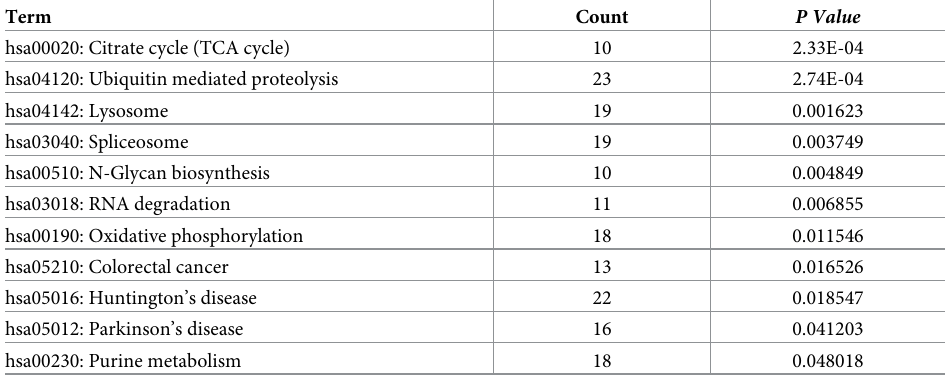
Table 3. KEGG enrichment using up-regulated genes.